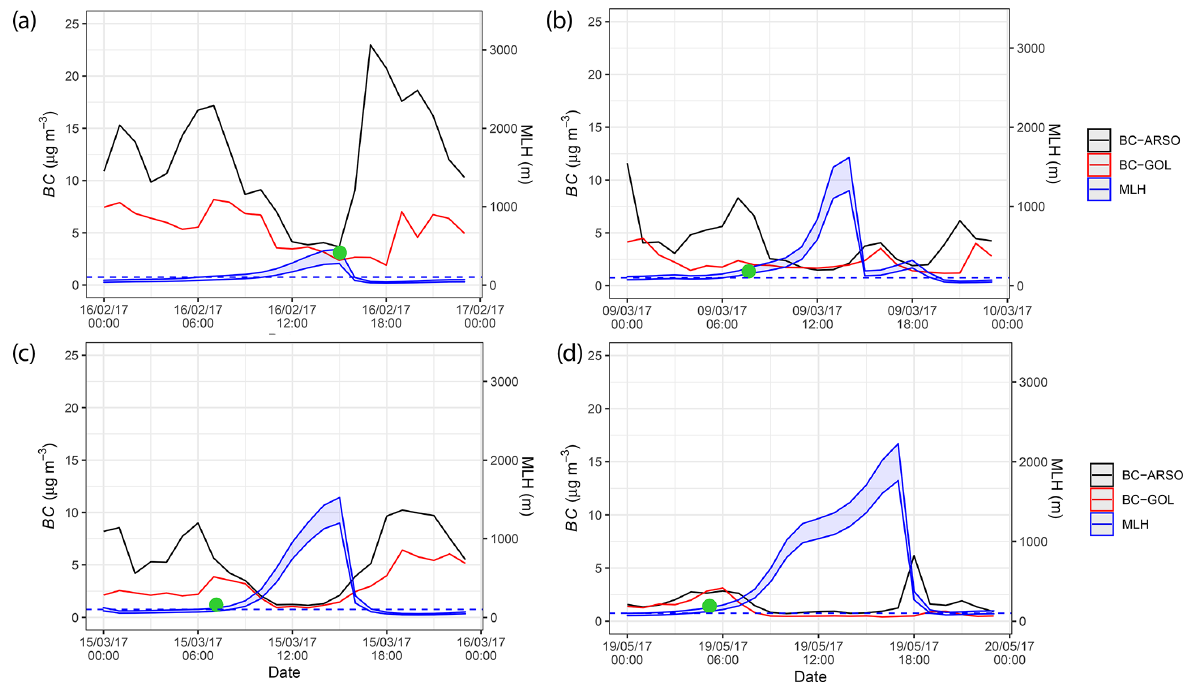
Figure 7. Time series (UTC) of BC concentration measured in Ljubljana (ARSO) and on the hill (GOL) with modelled MLH Rn (based on min and max E Rn estimate) in blue and MLH BC determined by flight measurements (green point) on 16 February 2017 (a) , 9 March 2017 (b) , 15 March 2017 (c) and 19 May 2017 (d) .